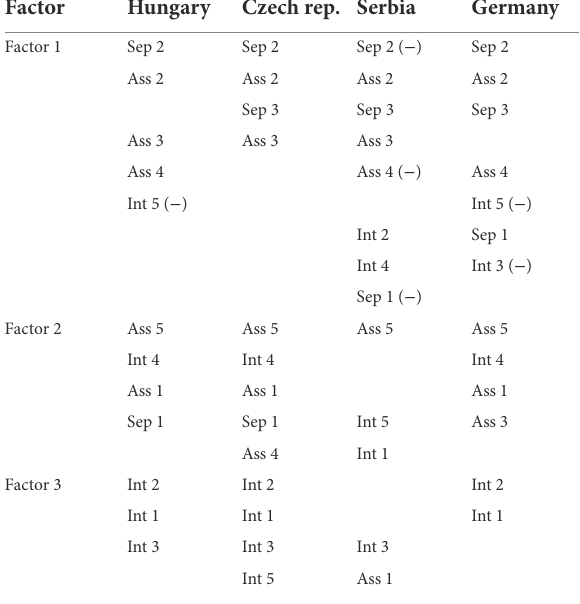
TABLE 2 Factor structure of the acculturation scale compared between the subsamples.